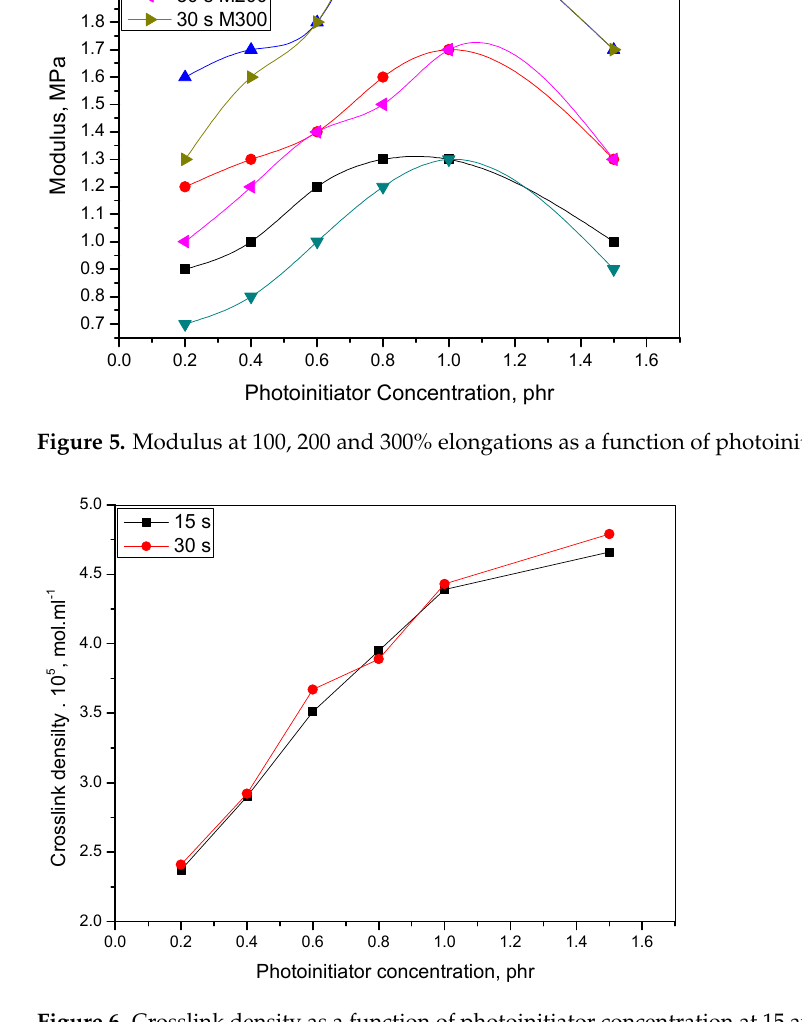
Figure 6. Crosslink density as a function of photoinitiator concentration at 15 and 30 s exposure